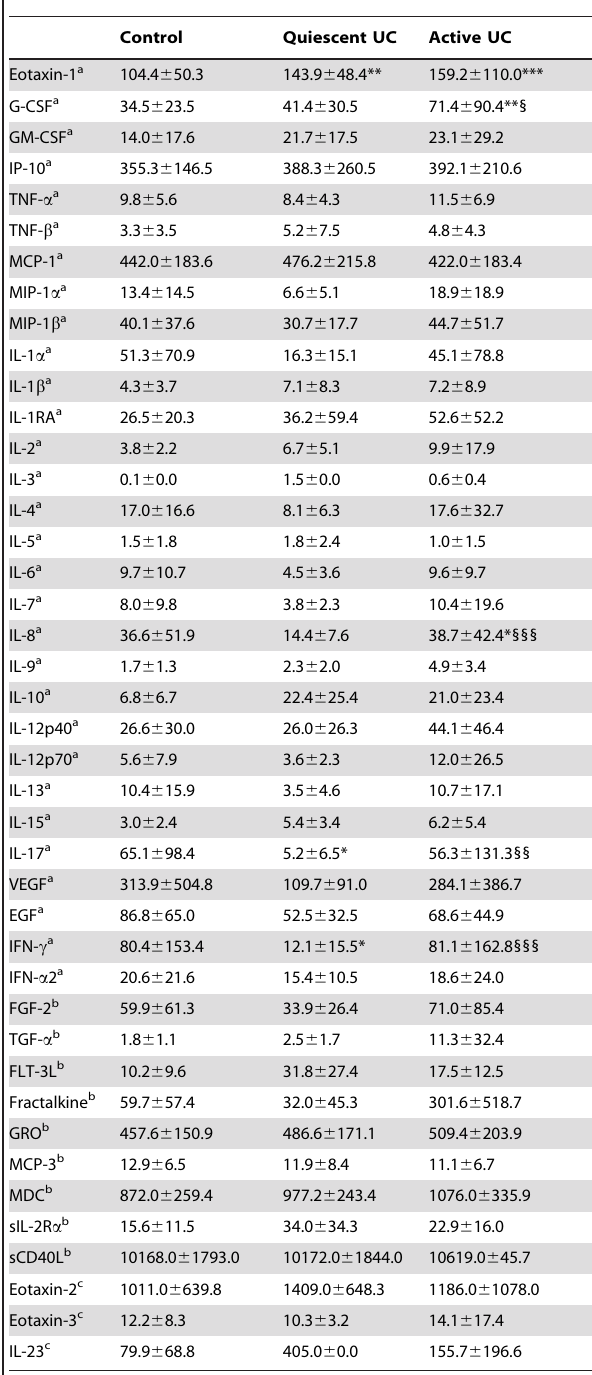
Table 2. Serum cytokine/chemokine